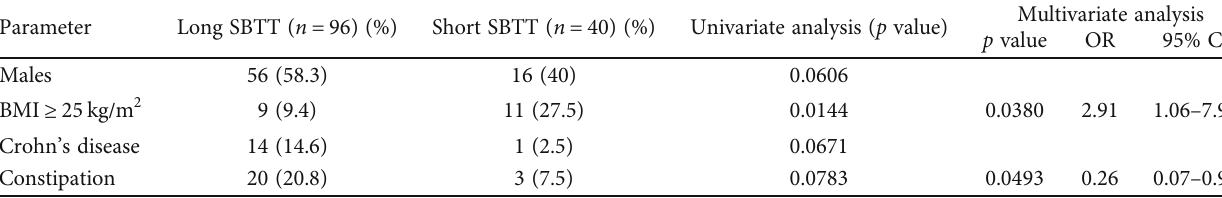
Table 5: Univariate and multivariate analyses of factors related to short SBTT in